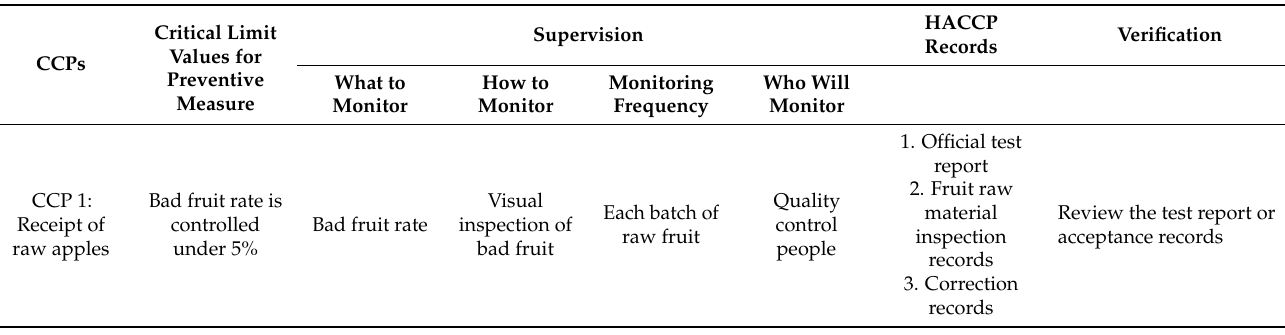
Table 2. HACCP plan for apple juice